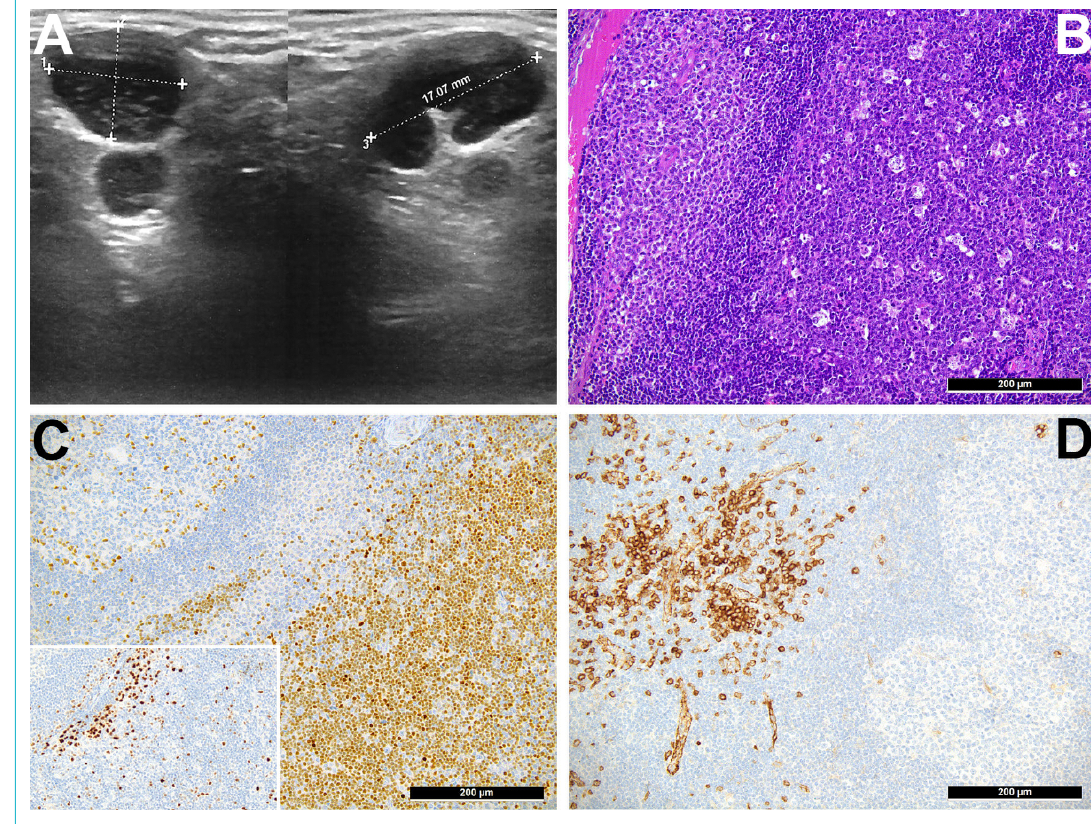
Figure 1: A. Ultrasonography revealed large supraclavicular lymph nodes of 17 × 13 × 10 mm. B. Medium power view of the enlarged lymph node showing follicular hyperplasia (dark purples cells intermingled with starry sky-appearing tingible body macrophages on right part) and monocytoid/plasmacytoid parafollicular hyperplasia (paler cell collection on the left side); Haematoxylin eosin stain, original magnification 200×. C. Significant T-helper 2 cell-skewing in the paracortex shown by the positive staining of the respective cellular compartment for GATA3, compared with the lower presence of T-helper 1-equivalents in the same area in the staining for T-bet/TBX21 (insert); immunoperoxidase staining, original magnification 200×. D. Significant increase of CD123-positive interferon-gamma-producing plasmacytoid dendritic cells in the parafollicular compartment; immunoperoxidase staining, original magnification